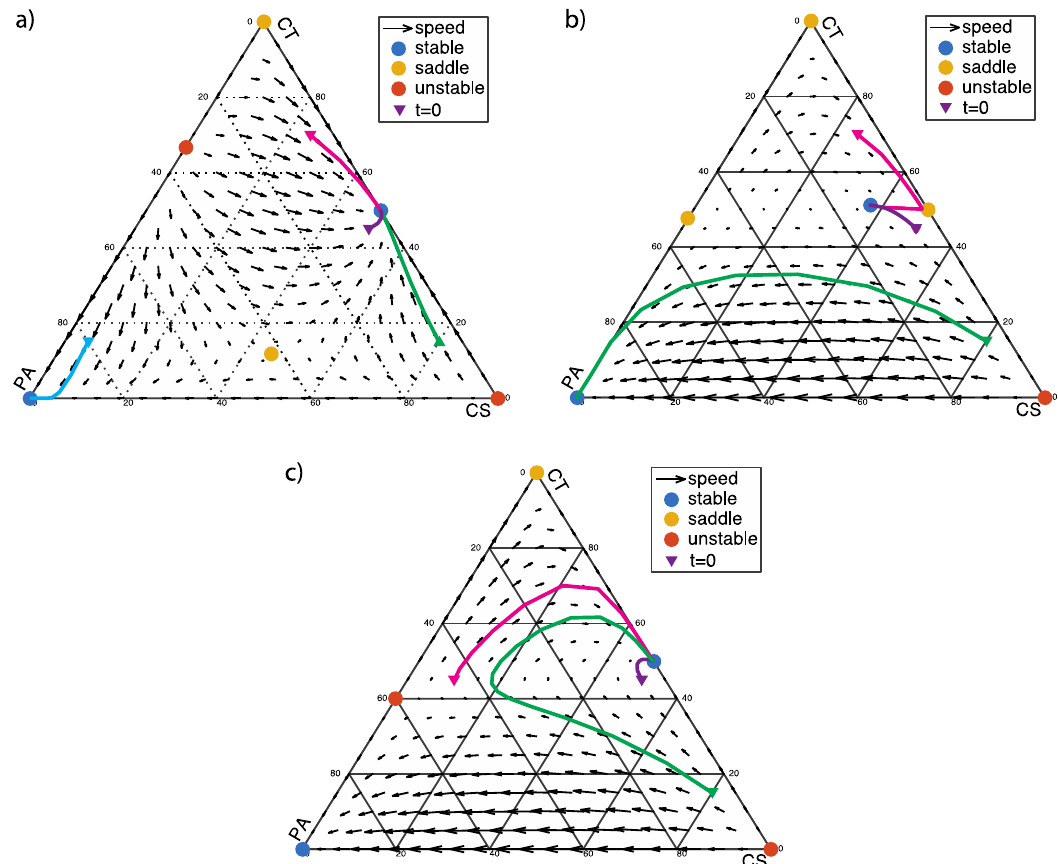
Figure 4. α < 0 and β < 0: The two vertices of the simplex at (1, 0, 0) and (0, 1, 0) are unstable and saddle points, respectively. There are two fixed points at the edges of the simplex: (1/2, 1/2, 0) (coexistence of CS and CT cells) and (0, 1/(1 − α ), − α /(1 − α )) (coexistence of CT and PA cells). ( a ) α < β + 1 and α ( β + 1) < 1, α = − 0.5, β = − 0.2; (0, 1/(1 − α ), − α /(1 − α )) is an unstable fixed point, and the interior fixed point is a saddle point; ( b ) α > β + 1and α ( β + 1) > 1, α = − 1.1, β = − 2.2; the points at (1/2, 1/2, 0) and (0, 1/(1 − α ), −α /(1 − α )) are saddle points; ( c ) α < β + 1 and α ( β + 1) > 1, α = − 1.5, β = − 2; (0, 1/(1 − α ), −α /(1 − α )) is an unstable fixed point.